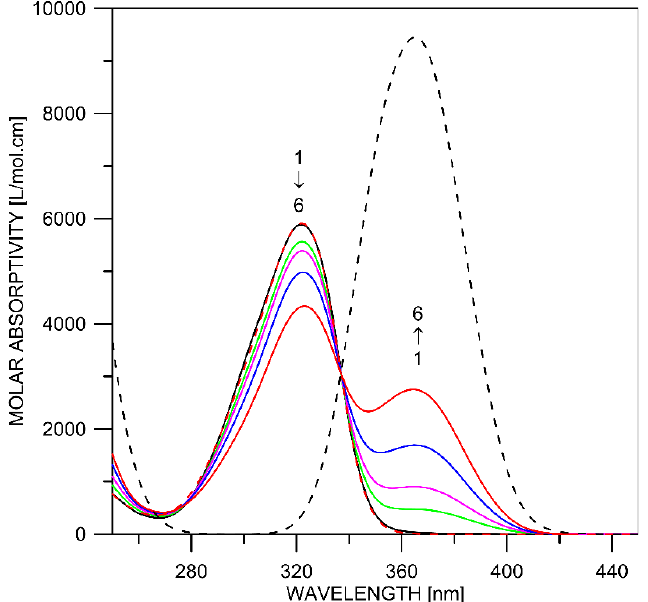
Figure 2. Absorption spectra of favipiravir in acetonitrile/water mixtures with stepwise decrease of the acetonitrile content: (1) 100% acetonitrile (0% water, black solid line), (2) 80% acetonitrile (20% water, green solid line), (3) 60% acetonitrile (40% water, magenta solid line), (4) 40% acetonitrile (60% water, blue solid line), (5) 20% acetonitrile (80% water, red solid line) and (6) calculated spectrum of the keto form (black dash line). The calculated spectrum of the pure enol form (red dash line) fully overlaps with curve (1).